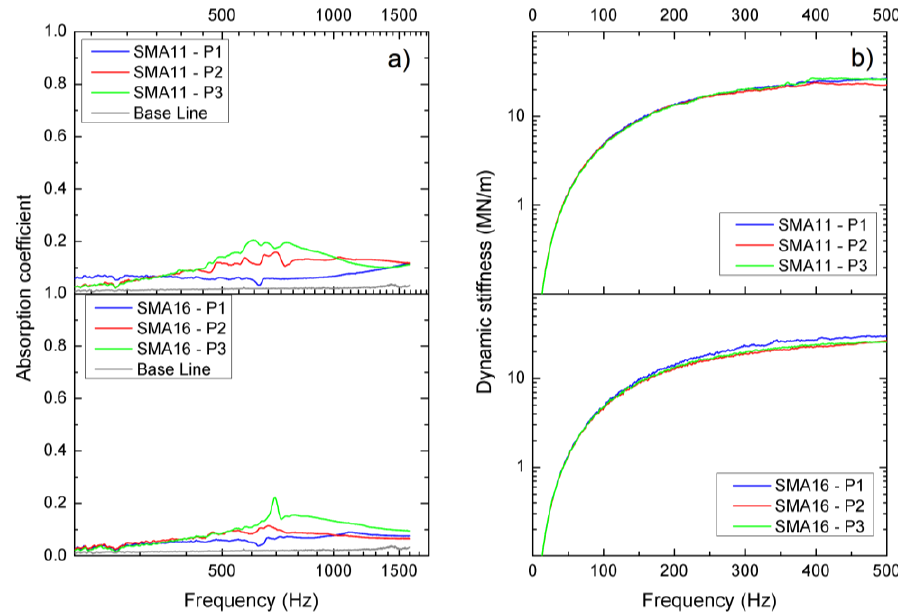
Figure 5. Acoustic absorption spectra ( a ) and dynamic stiffness spectra ( b ) of studied bituminous mixtures. Three sample cores were tested in each case.